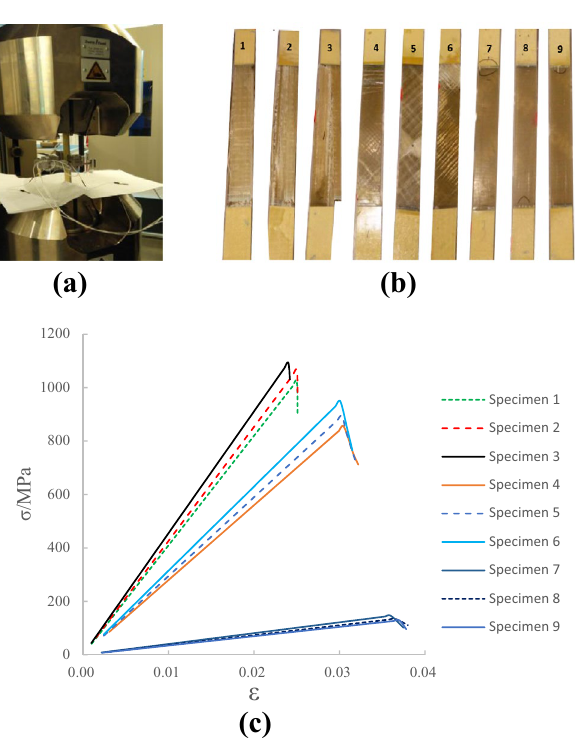
Figure 8. Strength test of the specimens. ( a ) Tensile test equipment. ( b ) Tensile failure photos of specimens. ( c ) Quasi-static tensile stress–strain